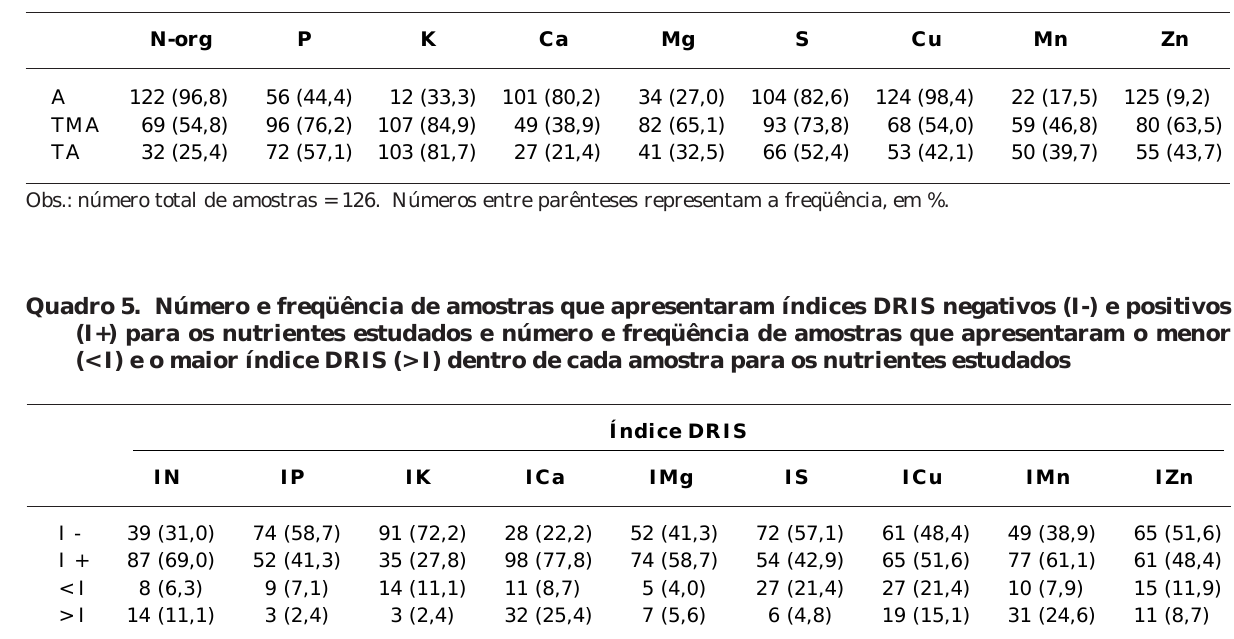
considerados adequados pela literatura (A), aos teores médios de nutrientes obtidos em canaviais de alta produtividade localizados em Campos dos Goytacazes (TMA) e aos teores adequados propostos por Reis Jr. (1999) (TA)